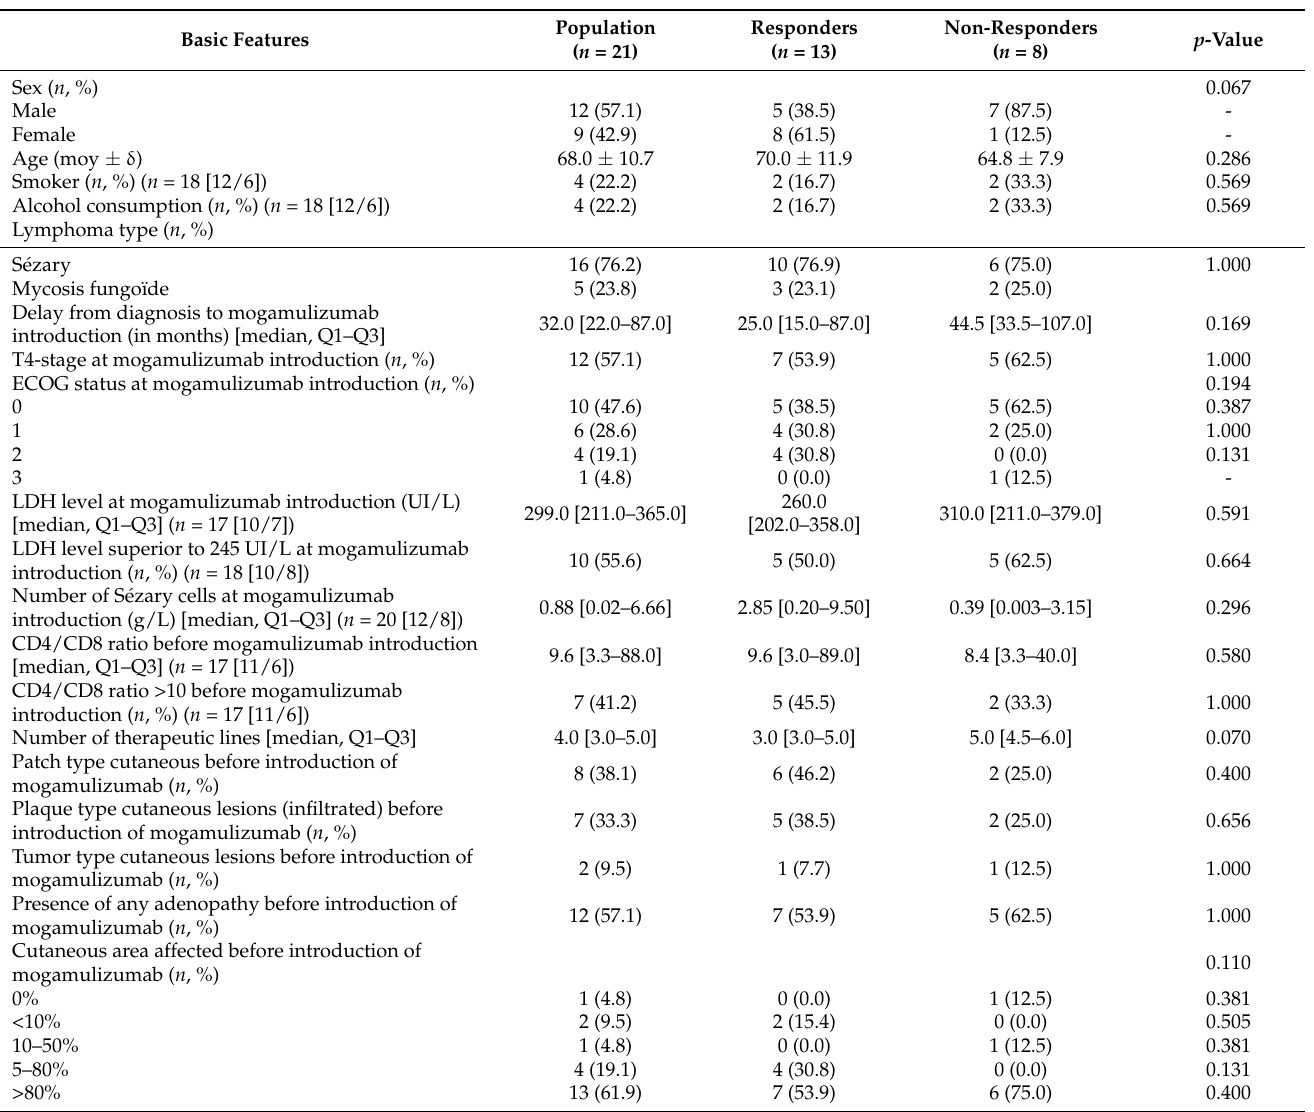
Table 1. Patient characteristics and comparison between responders and non-responders to moga- mulizumab. The p -value obtained using Khi-square or Fisher exact test for qualitative variables and using Student’s t-test or Mann–Whitney U test for quantitative variables, according to their